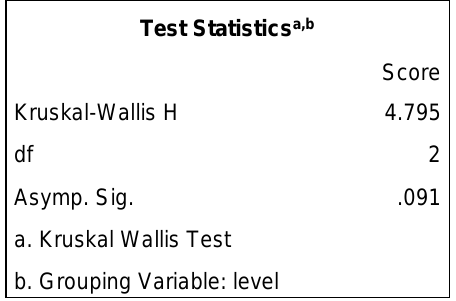
Table 3. Results of Kruskal-Wallis